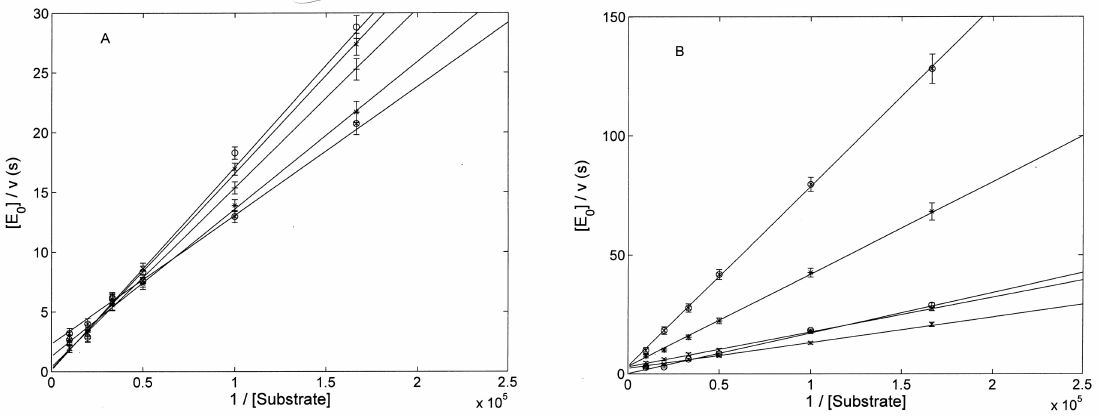
Figure 4. ( A ) Lineweaver–Burk double reciprocal plot as a function of substrate concentration of h20S ChT-L activity at different concentrations of TMPC, namely 0 (o), 0.1 µ M ( × ), 0.15 µ M (+), 0.3 µ M (*), and 0.5 µ M ( ⊗ ). Continuous lines are the non-linear least-squares fitting of data according to Equation (1). ( B ) Lineweaver–Burk double reciprocal plot as a function of substrate concentration of h20S ChT-L activity at different concentrations of TMPC, namely 0 (o), 0.5 µ M ( × ), 1.0 µ M (+), 3.0 µ M (*), and 6.0 µ M ( ⊗ ). Continuous lines are the non-linear least-squares fitting of data according to Equation